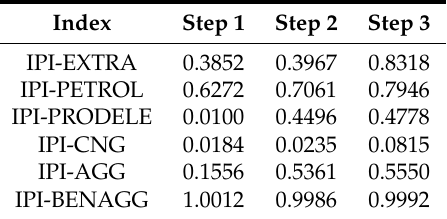
Table 30. Comparison of the ratio between RMSEs with an expanding window for electricity from 2008:01 to 2018:12.